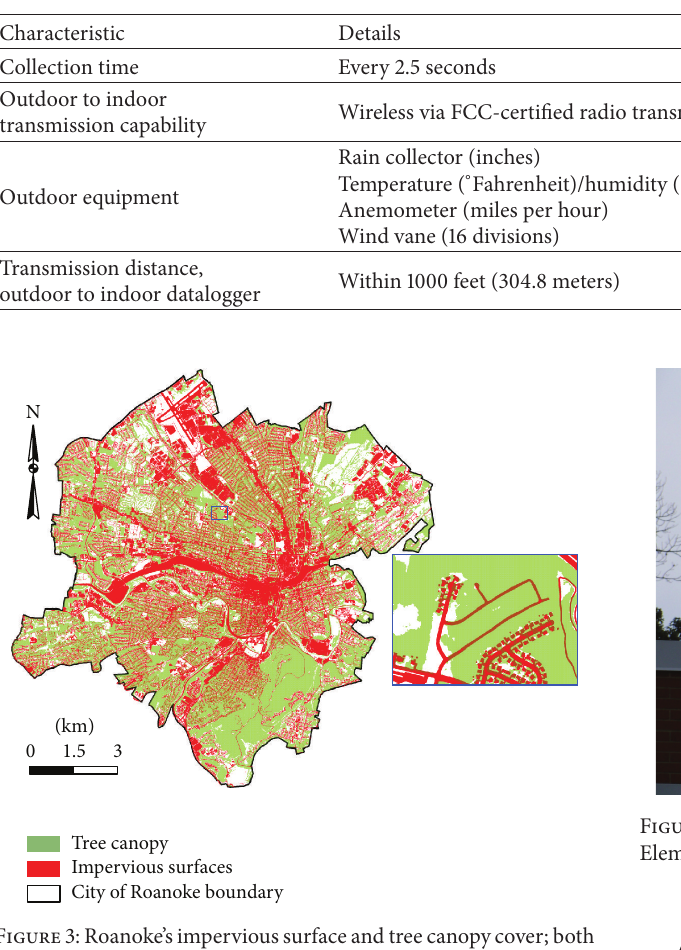
Figure 3: Roanoke’s impervious surface and tree canopy cover; both are not uniformly distributed. The inset illustrates that tree canopy and impervious surfaces can occupy the same area (reddish-brown color).